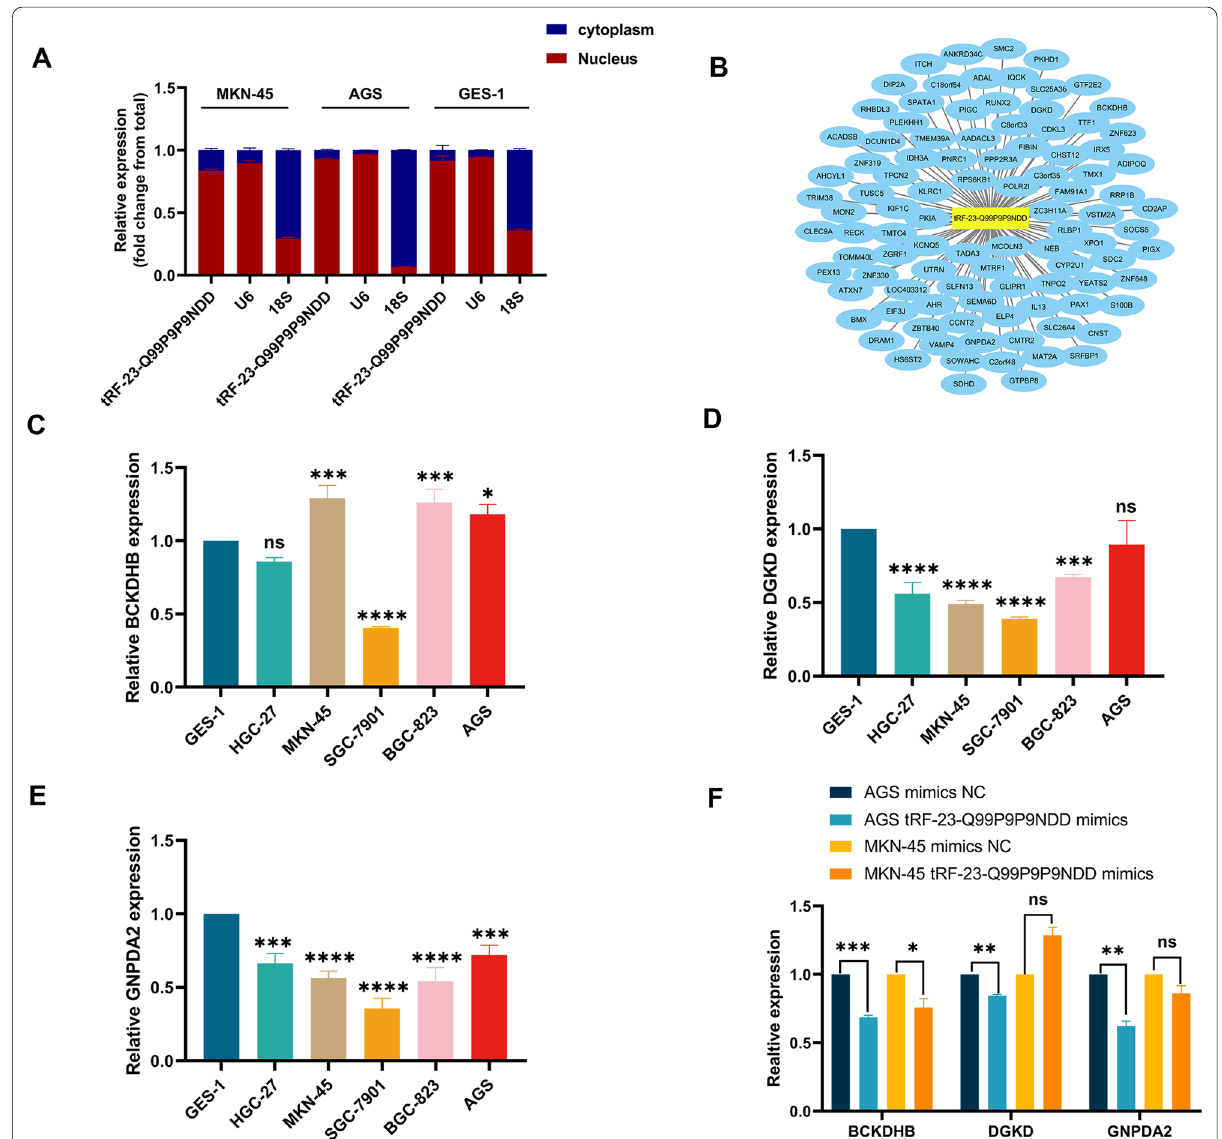
Fig. 6 Prediction of tRF-23-Q99P9P9NDD downstream in GC cells. A Nuclear and Cytoplasmic RNA Separation Assay was performed on MKN-45, AGS, and GES-1 for the detection of tRF-23-Q99P9P9NDD. B Potential target genes of tRF-23-Q99P9P9NDD. C The expression levels of BCKDHB in GC cell lines. D The expression levels of DGKD in GC cell lines. E The expression levels of GNPDA2 in GC cell lines. F The expression levels of three target genes in GC cell lines after transfection of tRF-23-Q99P9P9NDD mimics and mimics